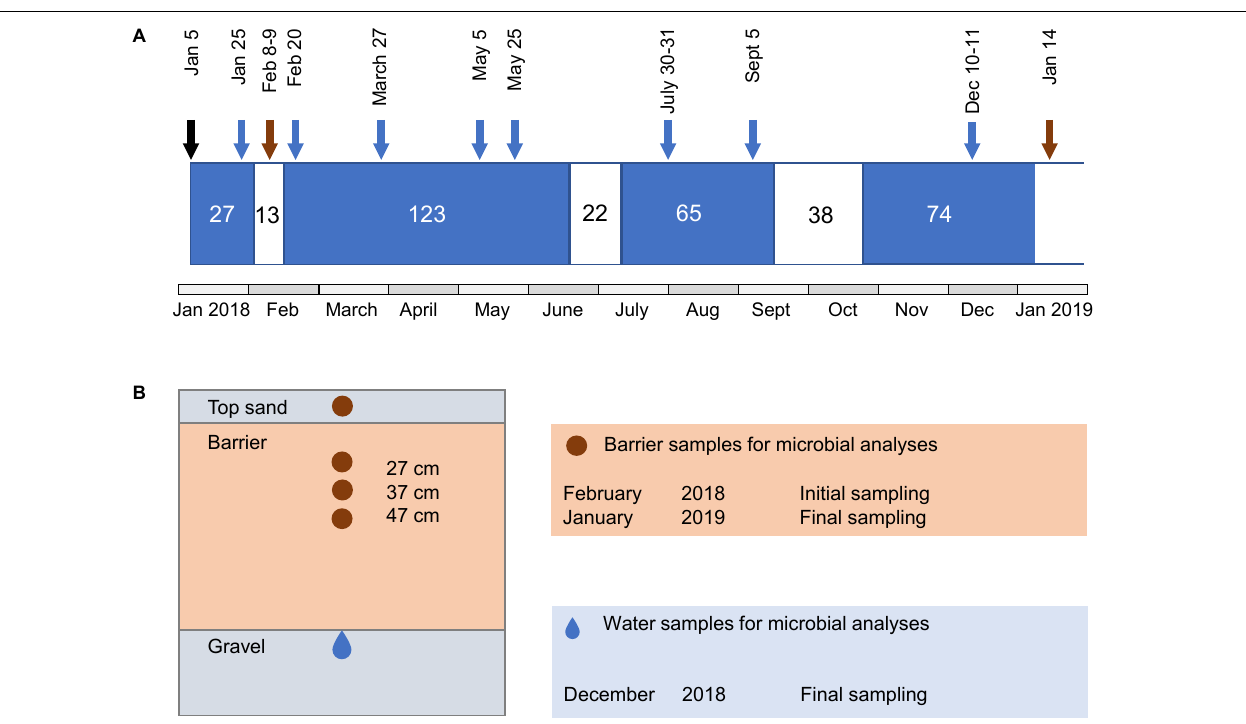
FIGURE 1 | Schematic illustration of the operational periods of the system, sampling time points, and sampling locations. (A) Length of wet (blue) and dry periods (white) and time points for water and barrier sampling. Sampling of barrier samples is indicated by brown arrows and water samples after barrier passage are indicated with blue arrows. The black arrow indicates the date of the first wet cycle. Microbial community analysis in water samples was only performed for the last sampling occasion. (B) Cross-section of the side view of barrier compartment, showing regions from where samples for characterization of microbial communities were taken. Brown area indicates barrier and gray areas indicate sand and